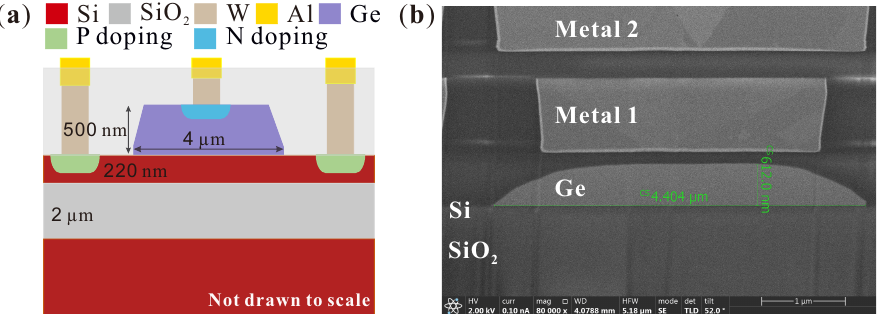
Figure 3. ( a ) Cross-section schematic of the fabricated vertical N(Ge)-I-P(Si) photodetector. ( b ) Scan- ning Electron Microscope (SEM) photo of the fabricated